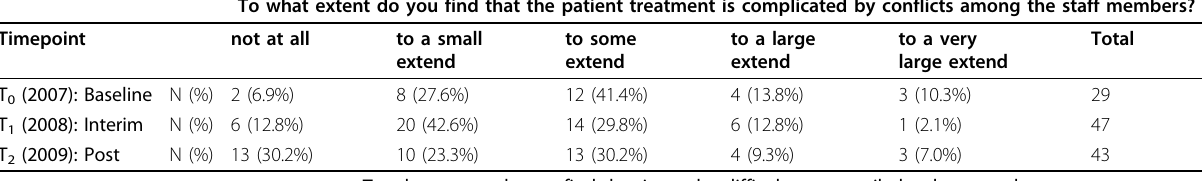
Table 3 Distribution of responses on the items of the “ Conflict"-subscale on the WES-10 before, within and after the team building process